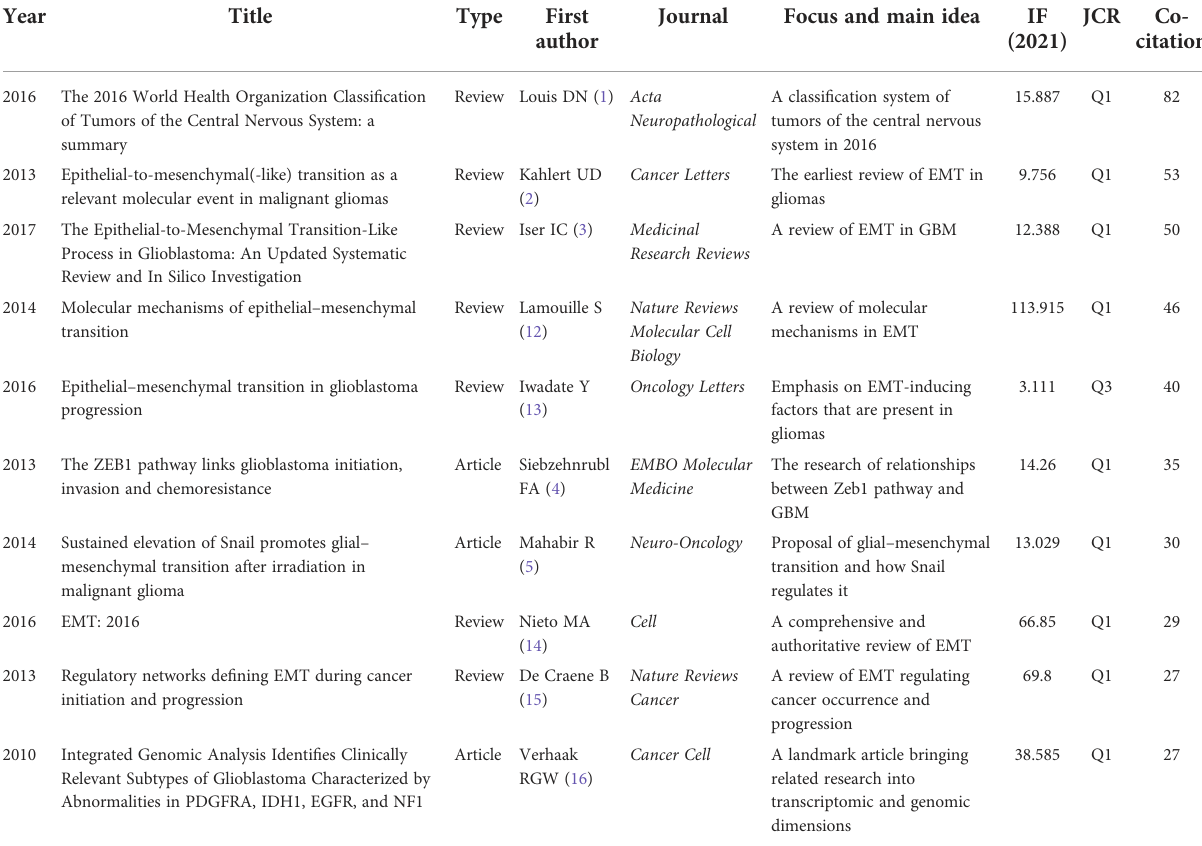
TABLE 1 The top 10 co-cited